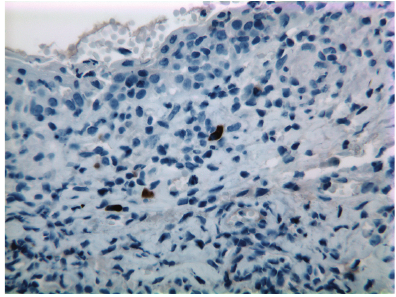
Figure 2: Left conjunctival biopsy with di ff use lymphocytic infiltrate (hematoxylin and eosin stain, 20x).